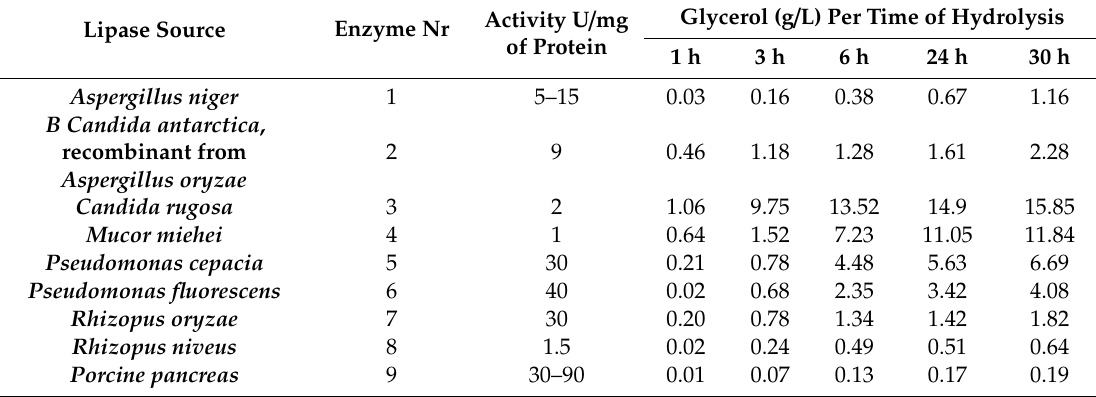
Table 4. Time-course production of glycerol during hydrolysis of waste animal fat by lipases of di ff erent